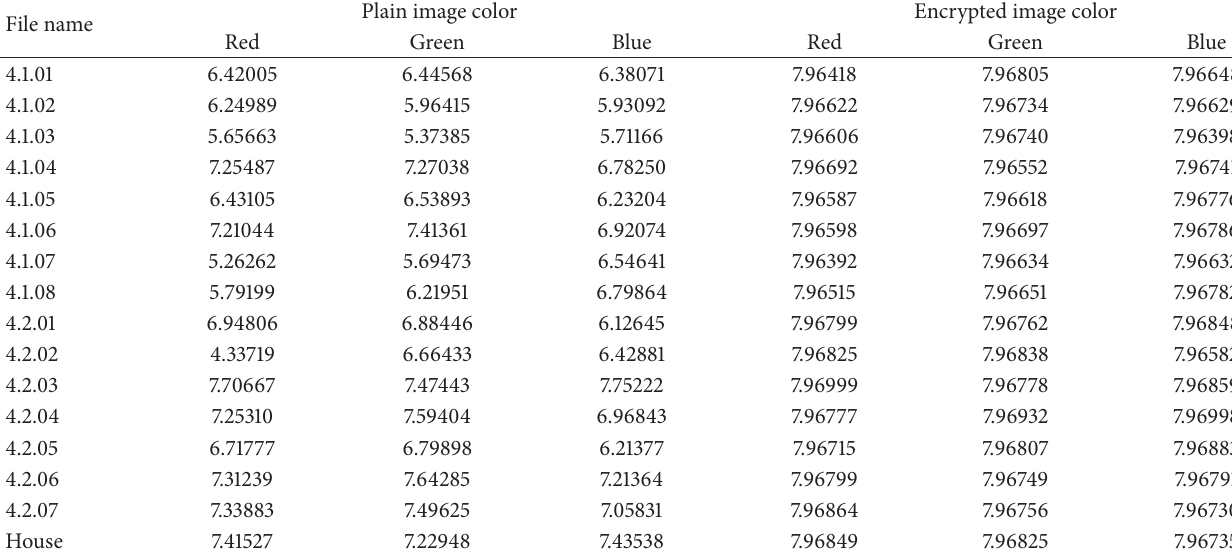
Table 5: Entropy results of plain images and encrypted